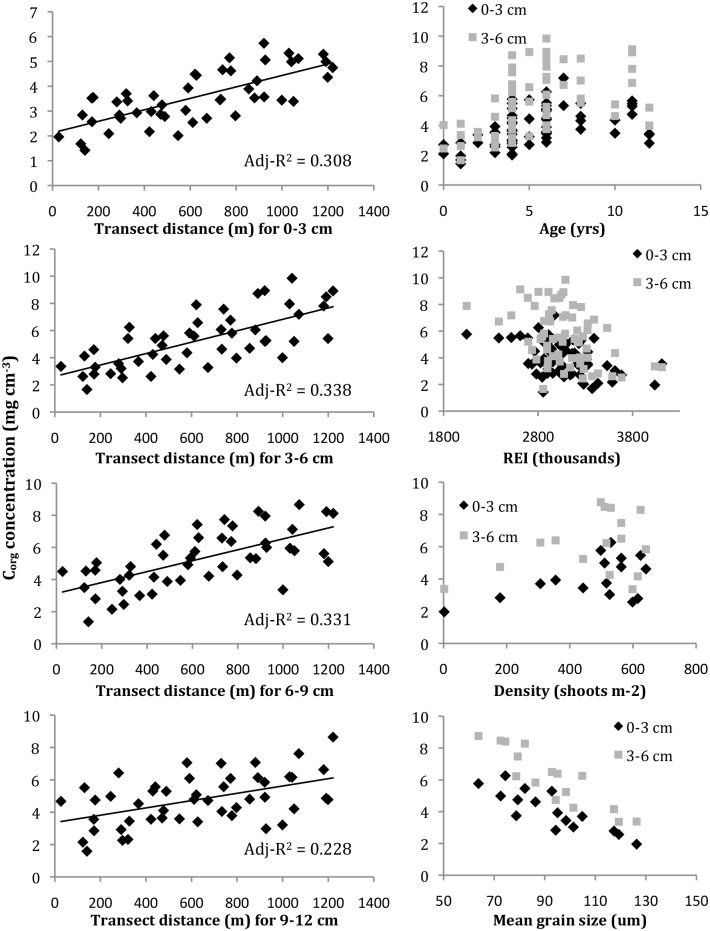
Sediment Corg concentration relationships with measured independent variables.Comparisons are by bed depth interval as noted; see Table 2 for individual regression statistics.